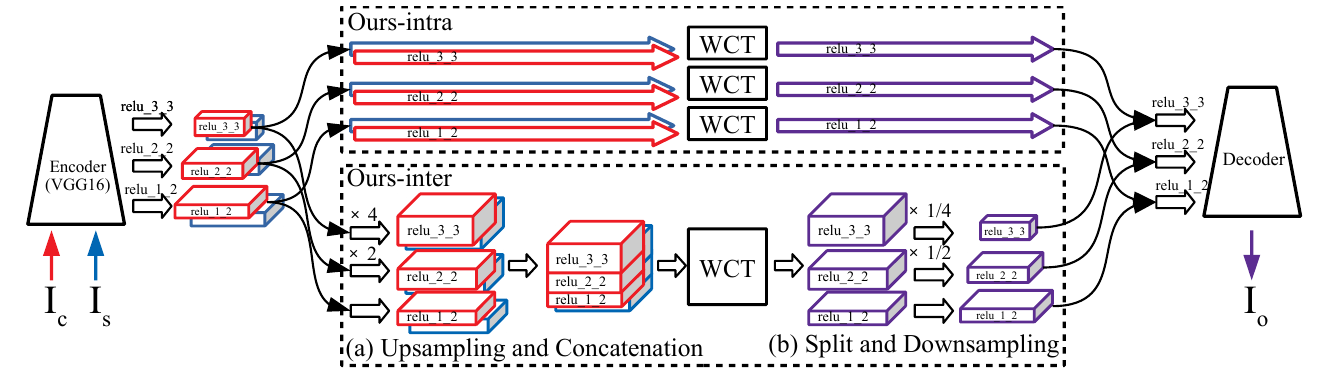
Figure 3. Each diagram shows the process of multi-scaled feature transform. Ours-intra presents multiple uses of SST to feature maps. Ours-inter represents merging multi-scaled features and dividing them into the original size for the inter-scale feature transform. ( a ) Merging multiple feature maps of several scales is performed as upsampling each scale feature by using nearest neighborhood interpolation to the largest size followed by concatenating them along the channel axis. ( b ) After feature transform, the transformed feature is split into multiple feature maps and downsampled into their original sizes. Each split feature is inserted into the decoder layer of the corresponding scale using